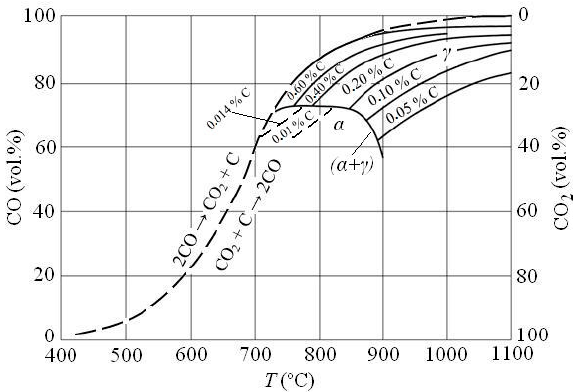
Figure 4. Equilibrium for gas mixtures (CO + CO 2 ) in the C-O system for the reactions of decarburization or carburization at pressure p = 1 atm; arranged according to [15,17].